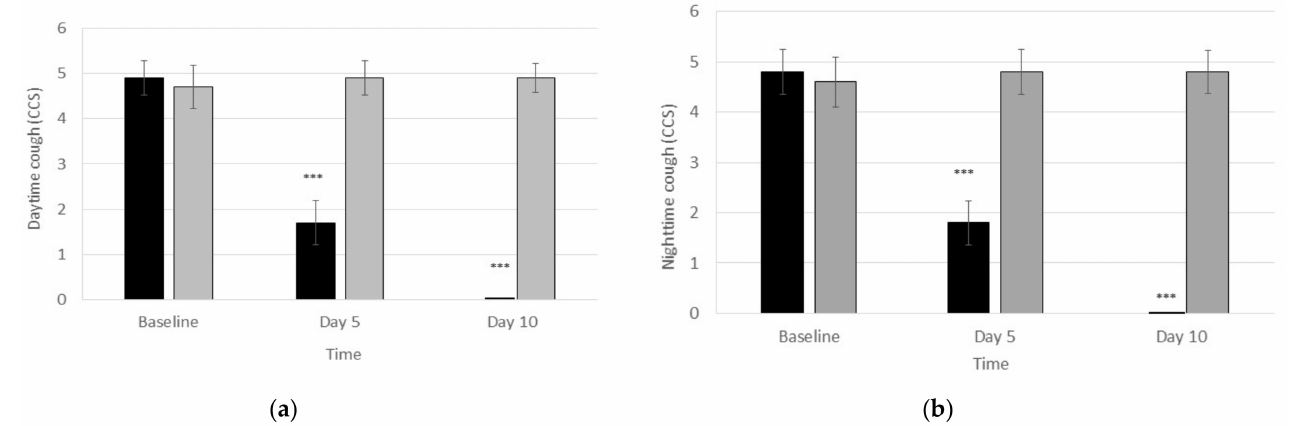
Figure 2. Cough Clinical Score (CCS). ( a ) Daytime cough CCS; ( b ) Nighttime cough CCS. Black bars: active; grey bars: placebo. *** p < 0.001 active vs.